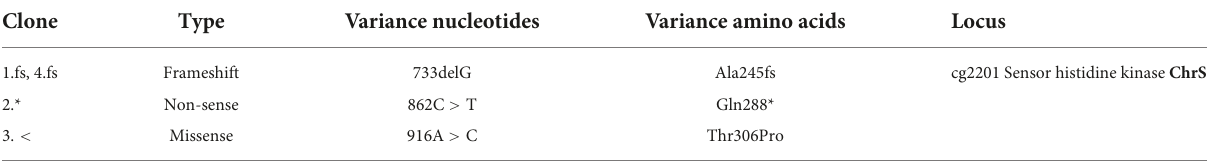
TABLE 1 Key mutations identified in C. glutamicum strains featuring increased heme tolerance.